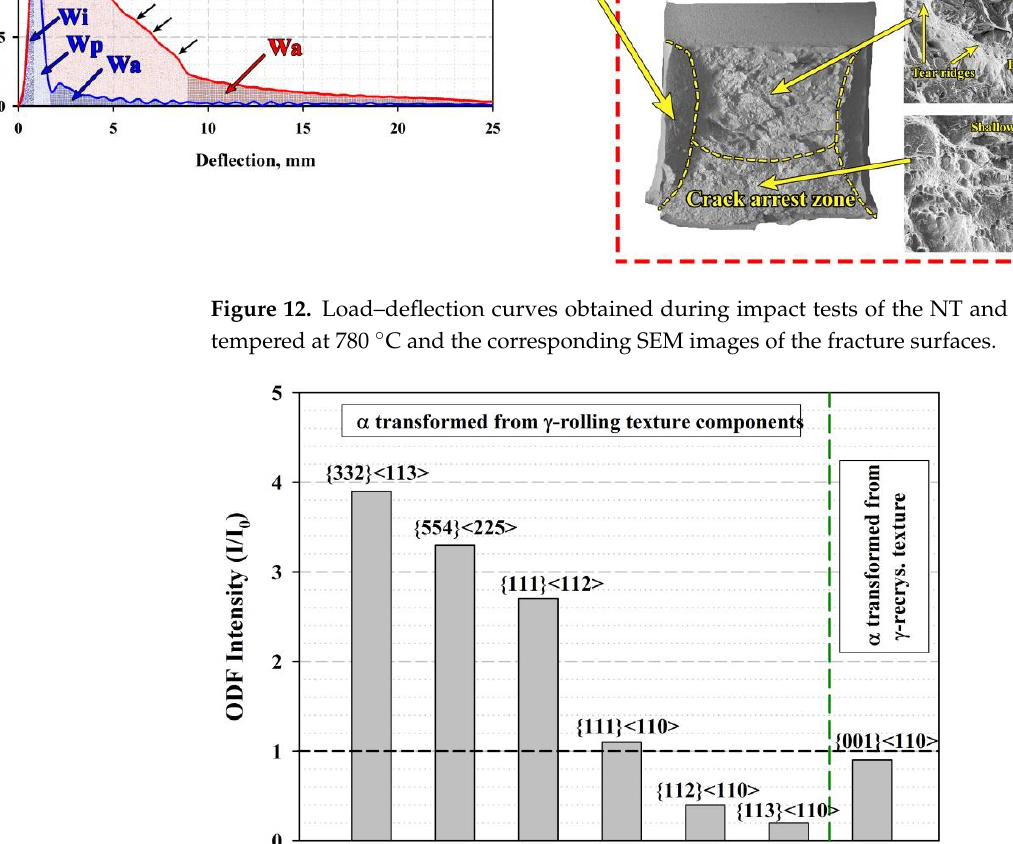
Figure 14. Load–deflection curves of the NT and HR+Q samples tempered at 780 °C and tested at −196, 20 and 150 °C. Figure 15 illustrates the fracture surface morphology of the steel samples tempered at 780 °C and tested at 150 °C. The dimple pattern produced by ductile tearing in the NT sample is characterized by a large number of small dimples, whereas the long and narrow dimples mixed with small round dimples appeared on the tear ridges in the HR+Q sam- ple. The ductile crack propagation involves the nucleation, growth and coalescence of mi- crovoids. The microvoids are formed around the second phase particles when sufficient stress is applied [41,47]. This is well agreed with in the SEM observations of the second phase particles inside the dimples (Figure 15).